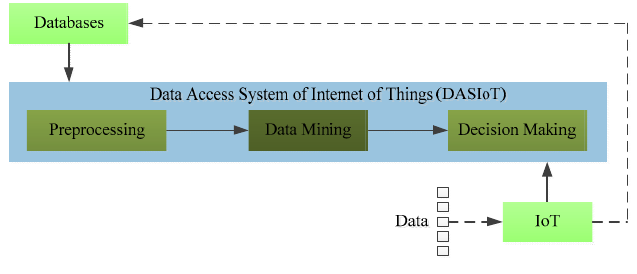
Figure 2. Basic structure of the DASIoT.